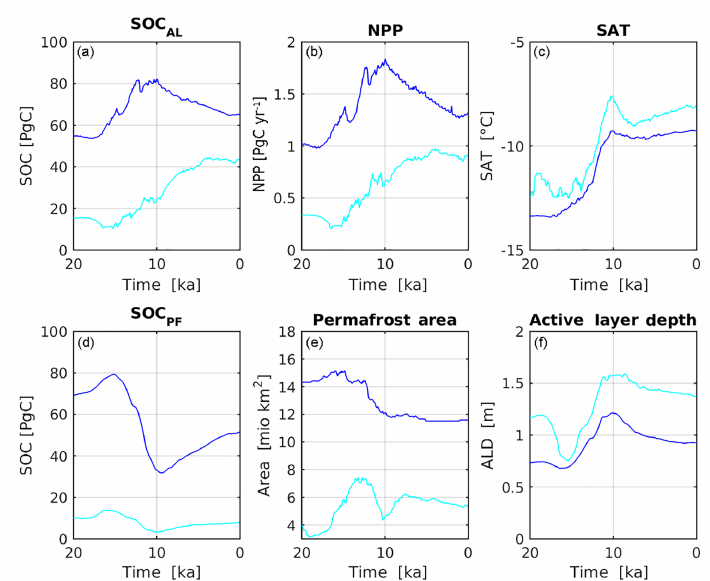
Figure A10. Deglacial evolution of seasonally thawed (a) and perennially frozen SOC (d) in near-surface permafrost from LGM to PI. Panels (b) and (e) show deglacial evolution of NPP summed over near-surface permafrost grid cells, and permafrost extent. Panels (c) and (f) illustrate mean annual surface air temperature and ALD, which both were weighted over permafrost grid cells. Contributions from North America (light blue) and Eurasia (dark blue) are shown